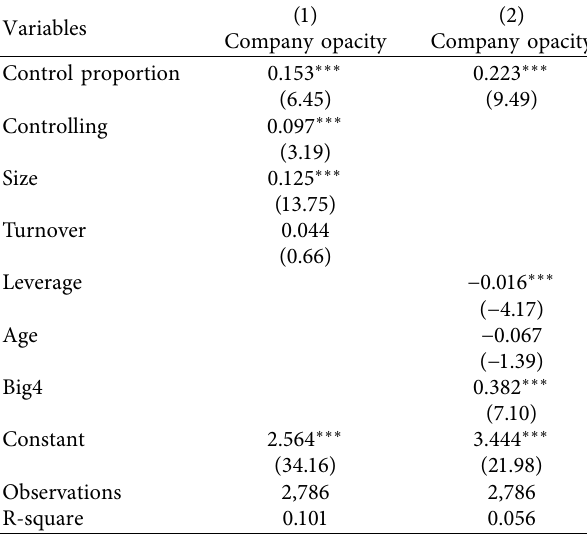
Table 6: The robustness tests of our main hypothesis is using the multiple linear regression model.